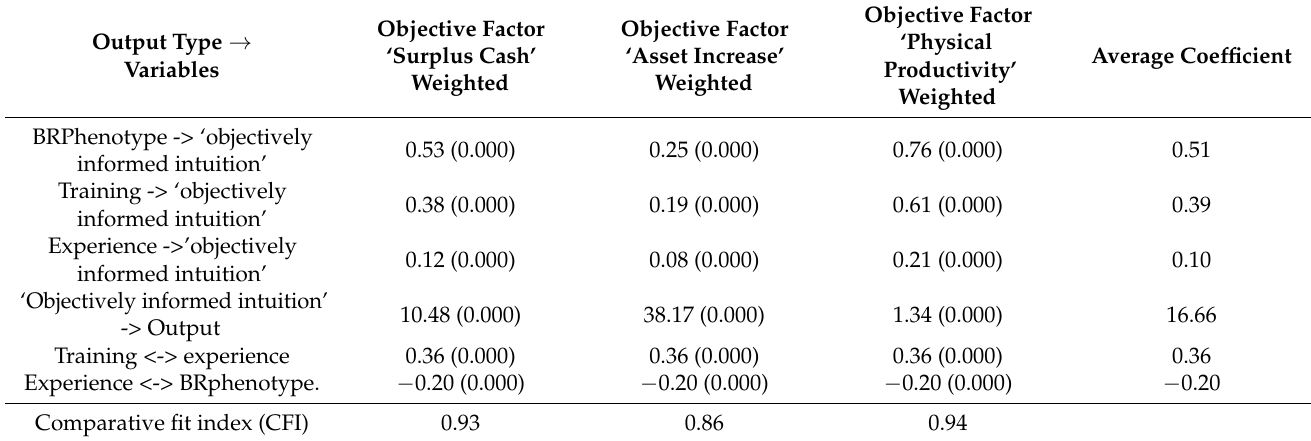
Table 5. The SEM solutions to the base form of Figure 1 expressing the importance of the core variables and their relationship with ‘objectively informed